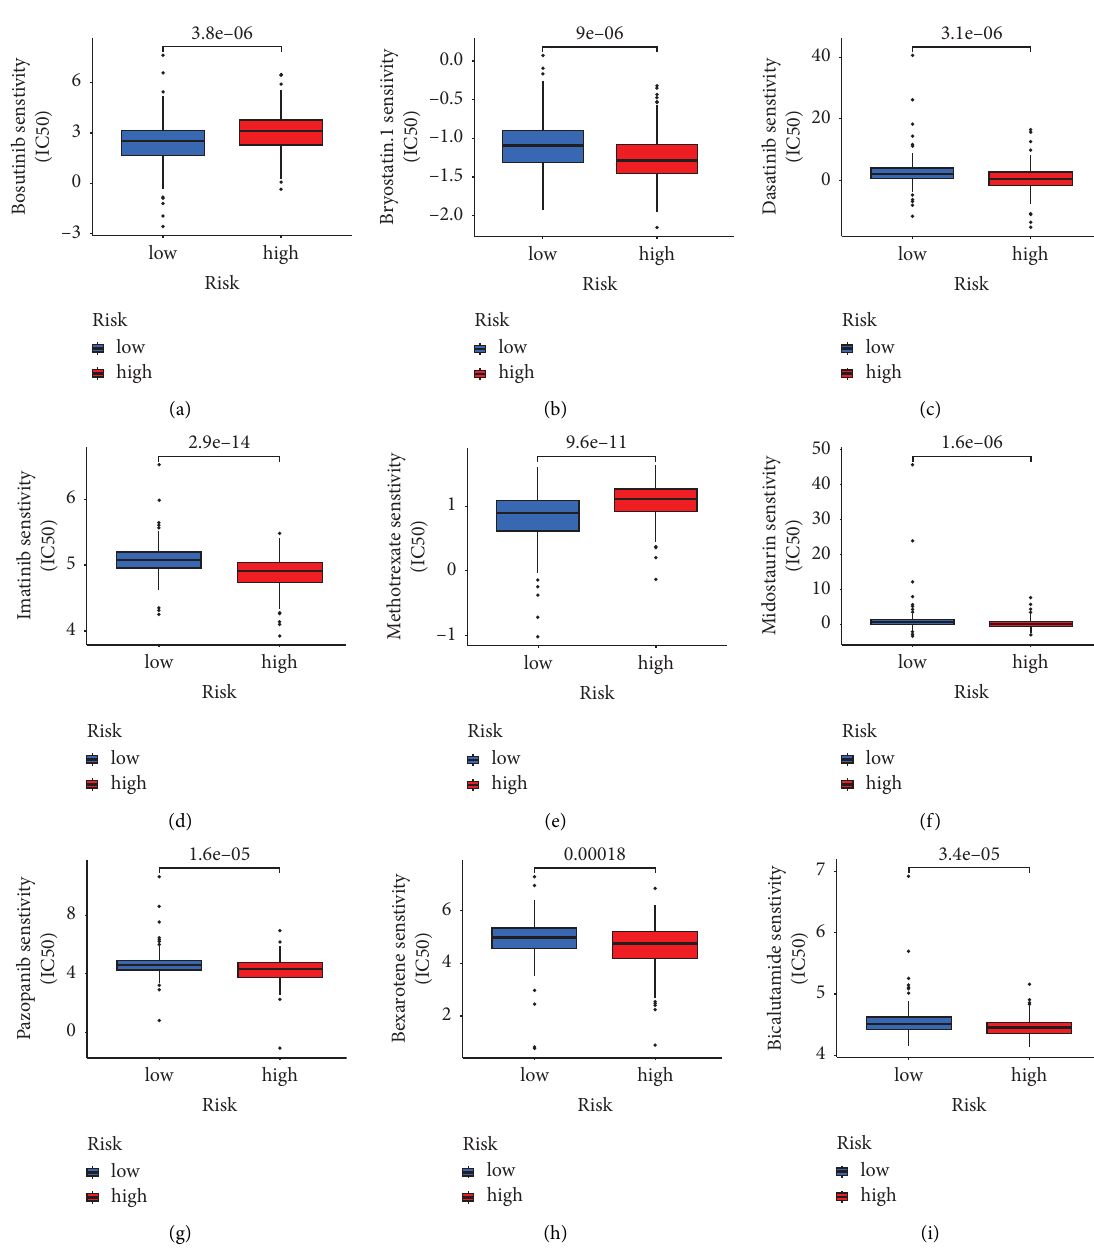
Figure 7: Te chemotherapy sensitivity of bosutinib (a), bryostatin.1 (b), dasatinib (c), imatinib (d), methotrexate (e), midostaurin (f), pazopanib (g), bexarotene (h), and bicalutamide